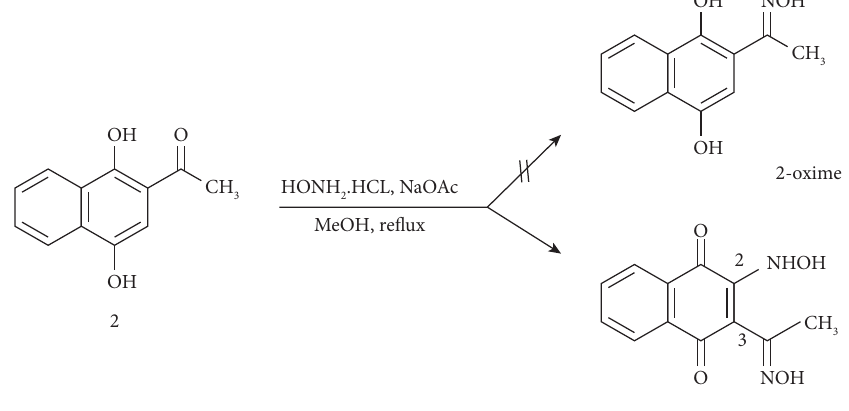
Scheme 2: Reaction of 2-acetylhydroquinone 2 with NH